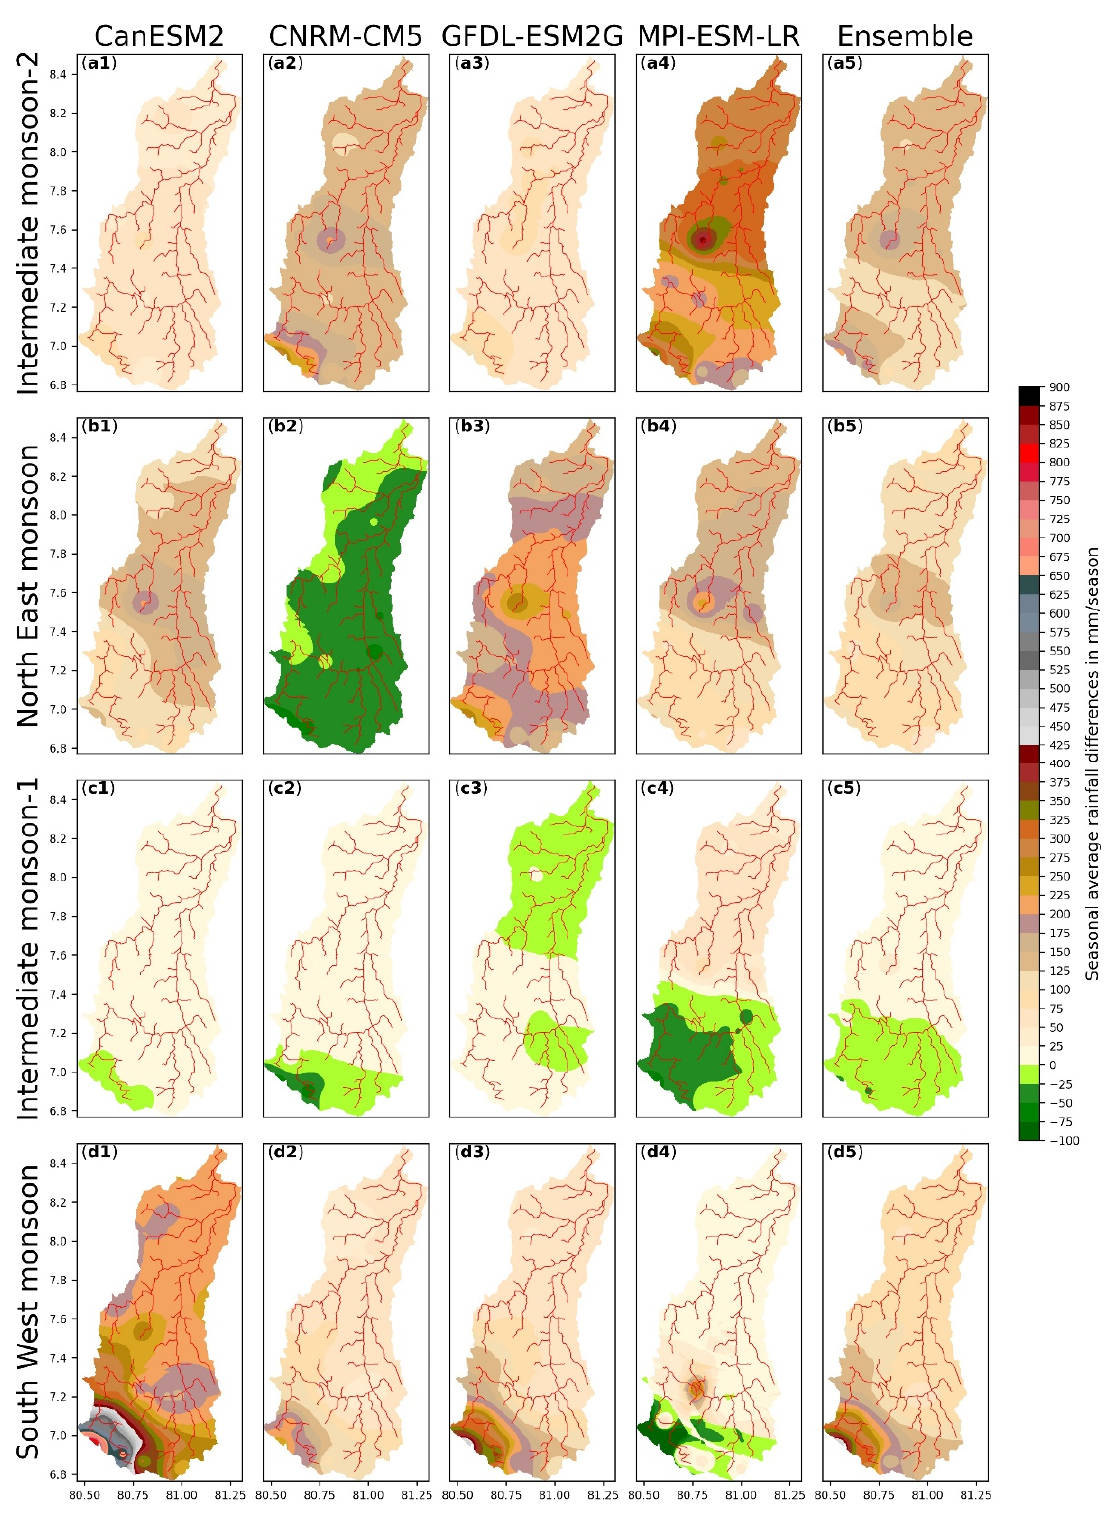
Figure 6. The comparison of seasonal average rainfall differences (future—past) for the selected models: CanESM2 ( a1 – d1 ), CNRM-CM5 ( a2 – d2 ), GFDL-ESM2G ( a3 – d3 ), MPI-ESM-LR ( a4 – d4 ) and the ensemble mean ( a5 – d5